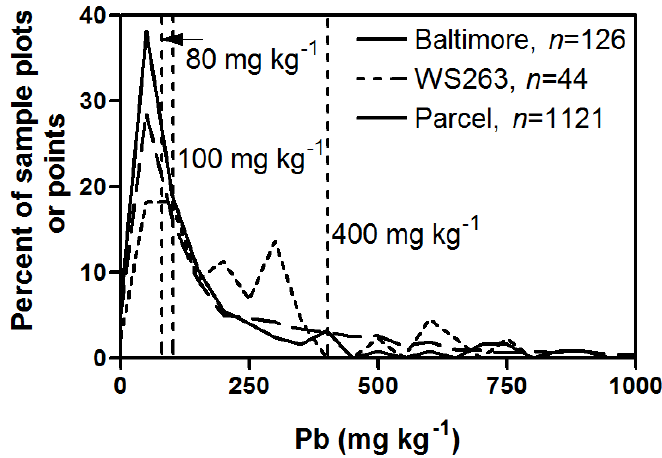
Figure 1. Plot frequency distributions of the percentage of sample plots or points having a specific lead concentration (mg ∙ kg − 1 ) measured for soils in the Watershed 263 neighborhood (solid line, plots), Baltimore City (dashed line, plots), and Baltimore City parcel (thin dashed line, points). A plot is a 0.04 ‐ hectare area where a composite sample was collected and analyzed for lead and a point is a lead value determined by X ‐ ray fluorescence multiple element analyzer on a residential property. There was one value for a plot and multiple for a residential property. The U.S. Environmental Protection Agency (EPA) soil screening levels (400 mg ∙ kg − 1 ), the EPA Technical Review Workgroup for Lead recommendation for urban gardening (100 mg ∙ kg − 1 ), and California state soil guideline (80 mg ∙ kg − 1 ) values are also shown. Data sources: Baltimore [3], Watershed 263 (unpublished), and Parcel [2]. Table 1. Percentage of plots (Watershed 263 and Baltimore City) or points (Parcel) that exceed the lead guideline values of 80, 100, 400, and 1200 mg ∙ kg − 1 and summary statistics. A plot is a 0.04 ‐ hectare area where a composite sample was collected and analyzed for lead and a point is a lead value determined by an X ‐ ray fluorescence multiple element analyzer on a residential property. There was one value for a plot and multiple for a residential property. Data sources: Baltimore [3], Watershed 263 (unpublished), and Parcel [2]. Guideline